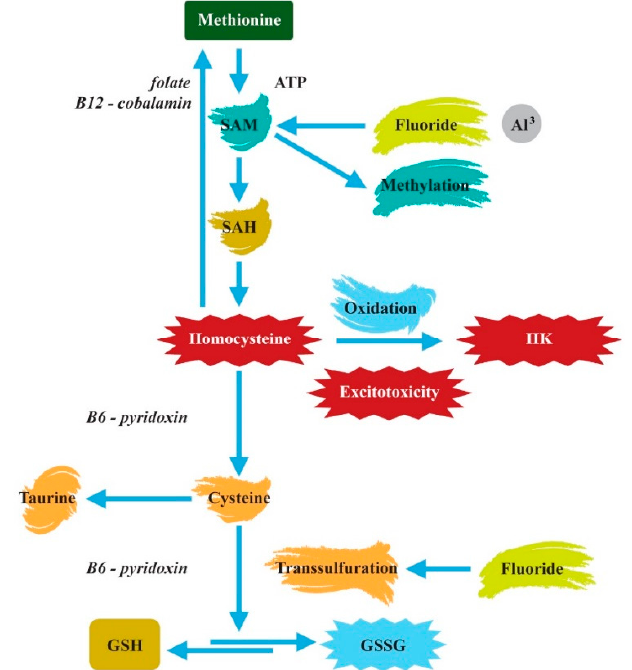
Figure 4. Methylation and transsulfuration metabolism in ASD. SAM—S-adenosyl methionine, SAH—S-adenosylhomocysteine, GSH—glutathione, GSSG—oxidized glutathione, ATP—adenosine